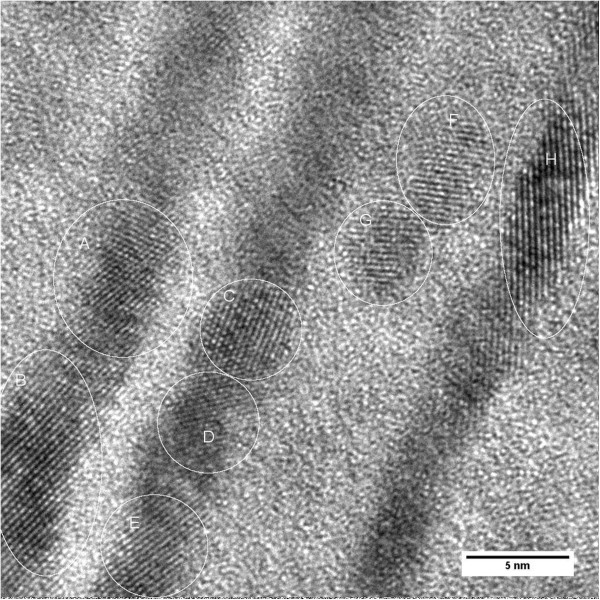
High-resolution lattice image of Al2O3/ZrO2(5:10 nm) multilayer film annealed at 1,273 K in HTXRD.